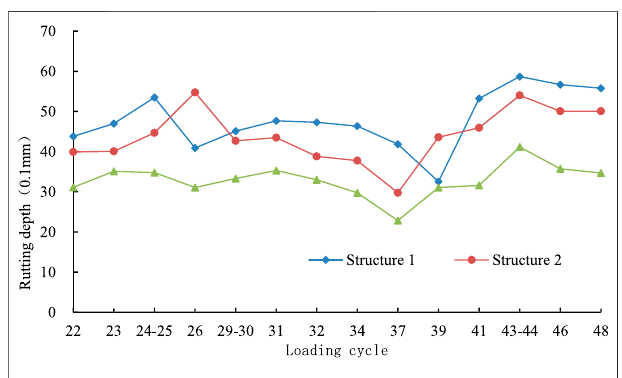
FIGURE 11 | Rutting test results of 3 m